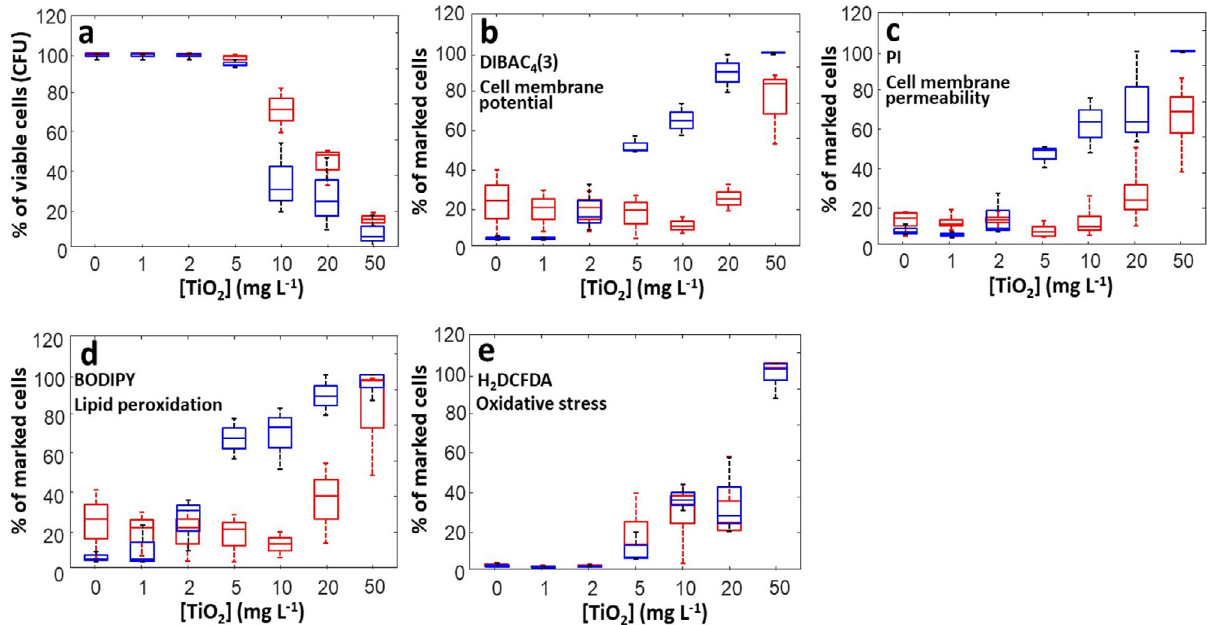
Fig. 2 JW3606 (hep + ) is the deep rough mutant that is most sensitive to TiO 2 NPs. a Dependence of JW3606 (hep + ) (blue) and JW3596 (hep − ) (red) viability on TiO 2 NP concentration. Normalized amounts of cells marked by membrane-selective fl uorescent dyes for assessment of TiO 2 NP effects on b cell membrane potential, c cell membrane permeability, d lipid peroxidation, and e oxidative stress. As in ( a ), results pertaining to JW3606 (hep + ) and JW3596 (hep − ) are represented by blue and red boxes, respectively, in the form of box plots. Data were derived from three independent experiments for each condition examined. The selected dyes and their targeted functions are speci fi ed for each panel with DIBAC 4 (3) = bis-(1,3-dibutylbarbituric acid) trimethine oxonol, PI = propidium iodide, BODIPY = 4,4-di fl uoro-5,7-dimethyl-4-bora-3a,4a-diaza-s-indacene-3-propionic acid, and H 2 DCFA = 2 ′ ,7 ′